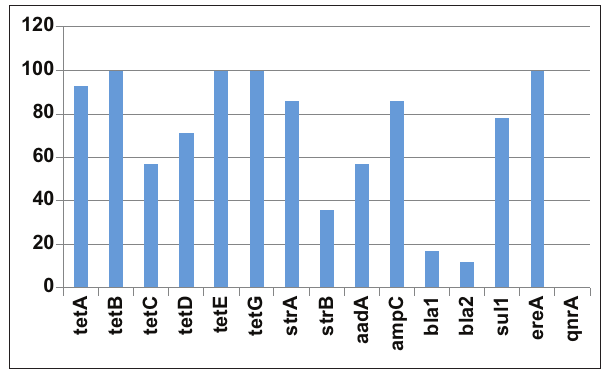
Figure-1: Frequency (%) of E. coli isolates from bovine mastitis carrying resistance genes against major antibiotic